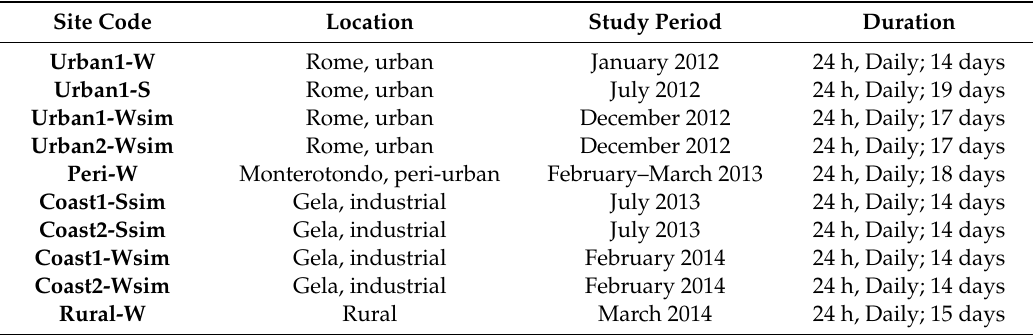
Figure 1. Inland and coastal locations of the six apartments under study. Table 1. Site identifying code, location and study period; details of the duration of each campaign.